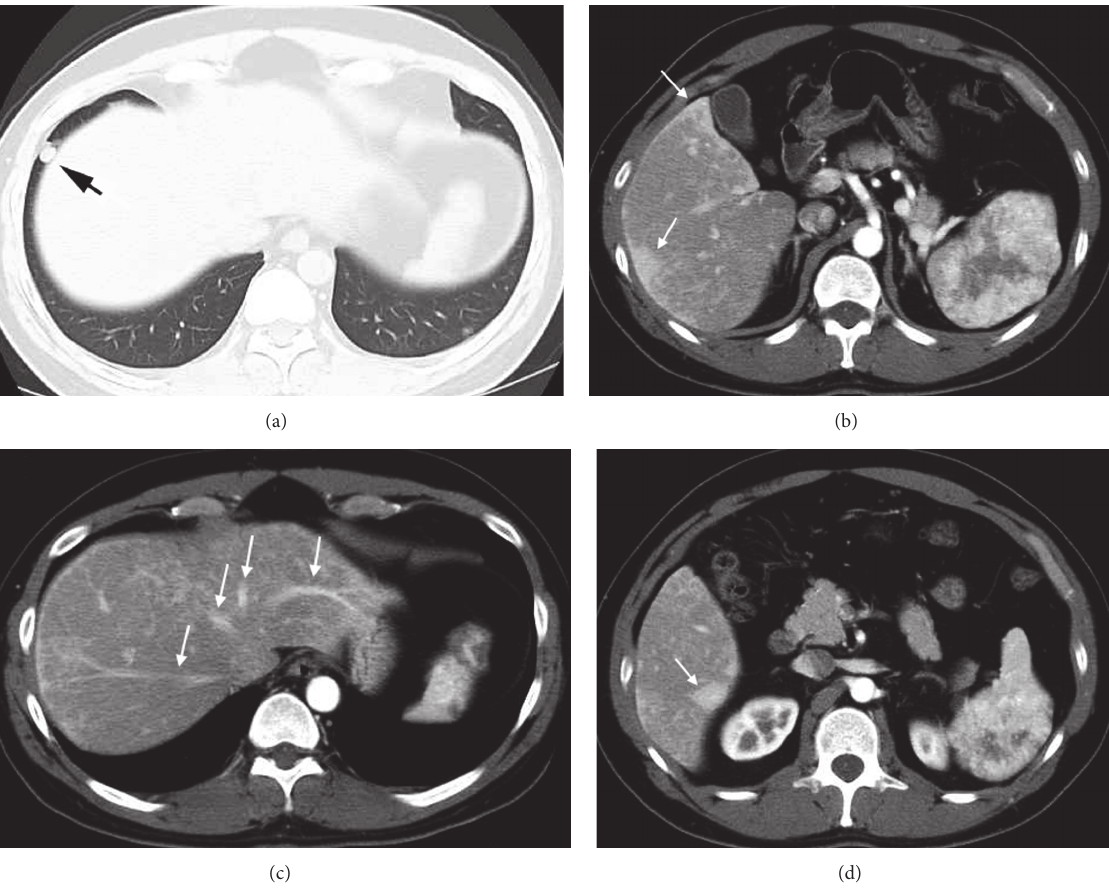
Figure2:ArterialphaseofenhancedCT,showing(a)apulmonaryarteriovenousmalformation(arrow);(b)transientperfusionabnormalities (arrow) in the periphery of the liver; (c) three major hepatic veins (arrow), suggesting arteriosystemic shunts of the liver; (d) a large confluent vascular mass (arrow) in the periphery of the